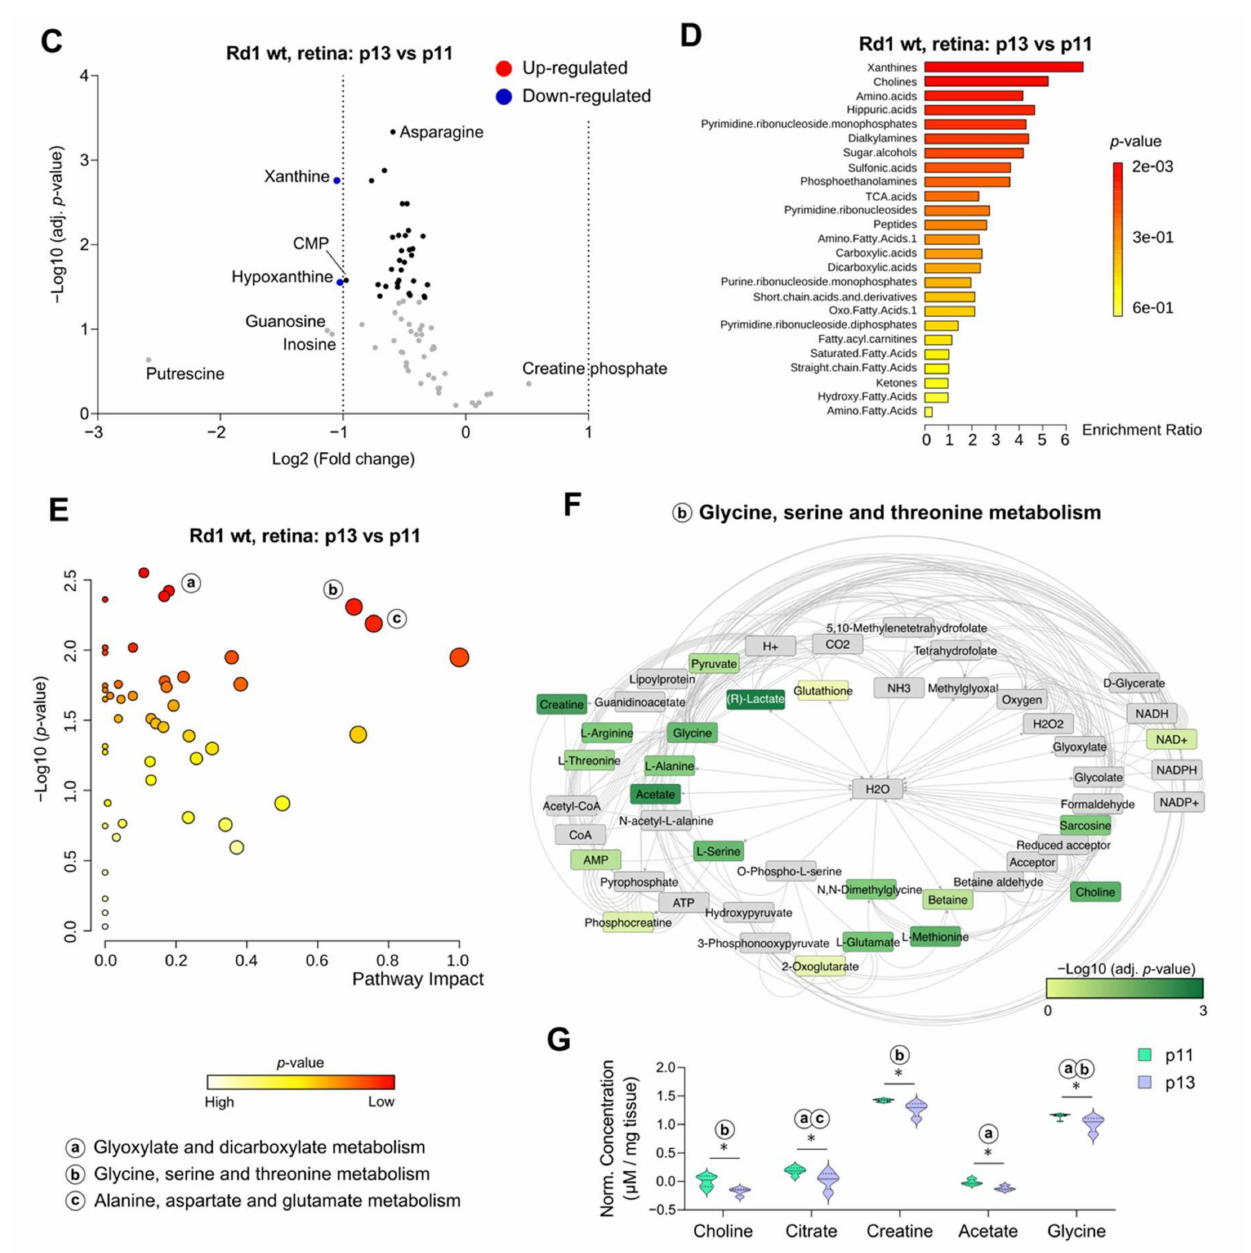
Figure 3. Metabolite analysis in the wt retina reveals distinct differences caused by eye opening. Volcano plot ( A ) and related quantitative metabolite set enrichment analysis ( B ) illustrating changes in the metabolite concentration in the vitreous/lens of Rd1 wt mice between time-points p13 and p11. Volcano plot ( C ) and related quantitative metabolite set enrichment analysis ( D ) illustrating changes in the metabolite concentration in the retina of Rd1 wt mice between time-points p13 and p11. ( E ) Pathway analysis of the retina data depicted in subfigures ( C , D ), showing the significance of the time-point comparison in relation to the topology (impact). Small letters indicate the pathways in the legend. ( F ) Cytoscape network representation of pathway “b” selected from subfigure ( E ). The metabolites with a match in the pathway are shown color-coded according to their significance in our analysis. ( G ) Violin plots of metabolites selected in subfigure ( F ) for their significance, showing their concentrations at both time-points. The letters indicate the corresponding pathway from subfigure ( E ) in which the metabolites are found. Vitreous/lens: n = 6 (p11), n = 5 (p13). Retina: n = 7 (p11), n = 4 (p13). Multiple unpaired t test with Holm-Š í d á k correction for multiple comparisons. * p < 0.05.